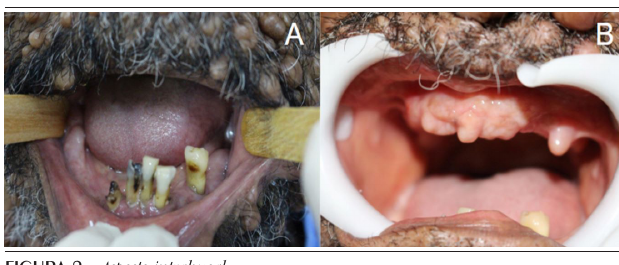
FIGURA 2 – Aspecto intrabucal